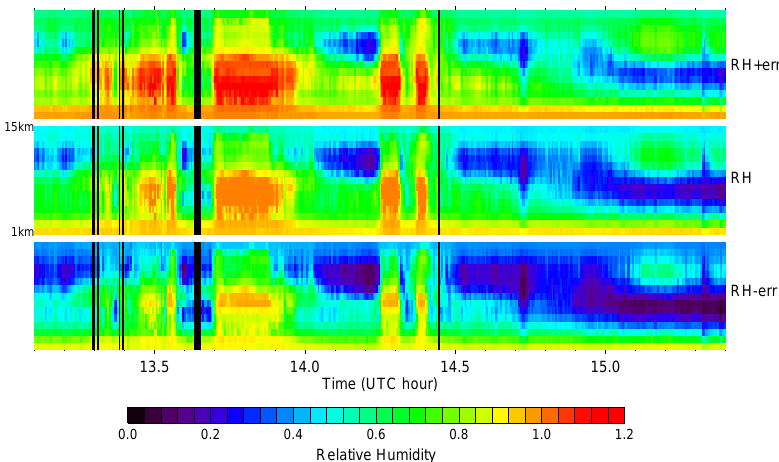
Fig. 22. Relative humidity profiles retrieved from nadir CoSSIR data from 1 to 15km at 1km resolution.